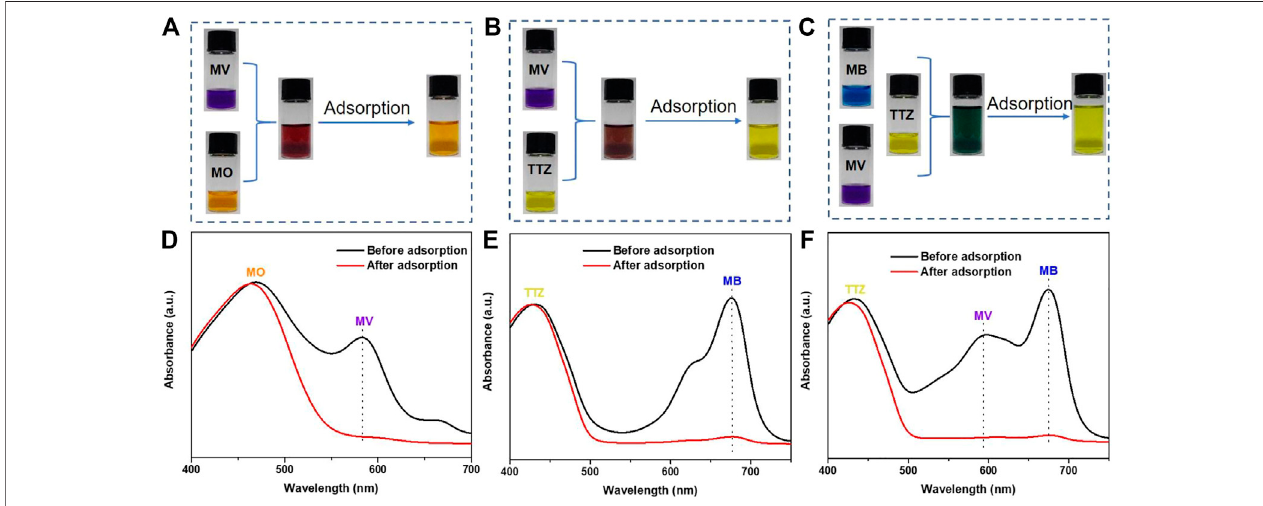
FIGURE 8 | Photographs of the dye mixture of MV/MO (A) , MV/TTZ (B) , and MB/MV/TTZ (C) before and after adding PFPCS for 60 min at pH (cid:2) 8. The initial dye concentration in the mixture is 0.1 mM. The corresponding absorption spectra of the dye mixture of MV/MO (D) , MV/TTZ (E) , and MB/MV/TTZ (F) before and after adsorption by PFPCS.